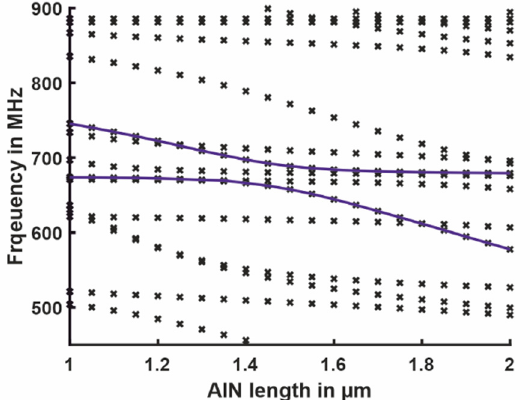
Figure 10. Parameter dependence of all eigenfrequencies on the different length of the piezoelectric element in the frequency range from 450 to 900 MHz, as indicated by makers. The lines show the change of the two utilized eigenmodes ω L and ω H .